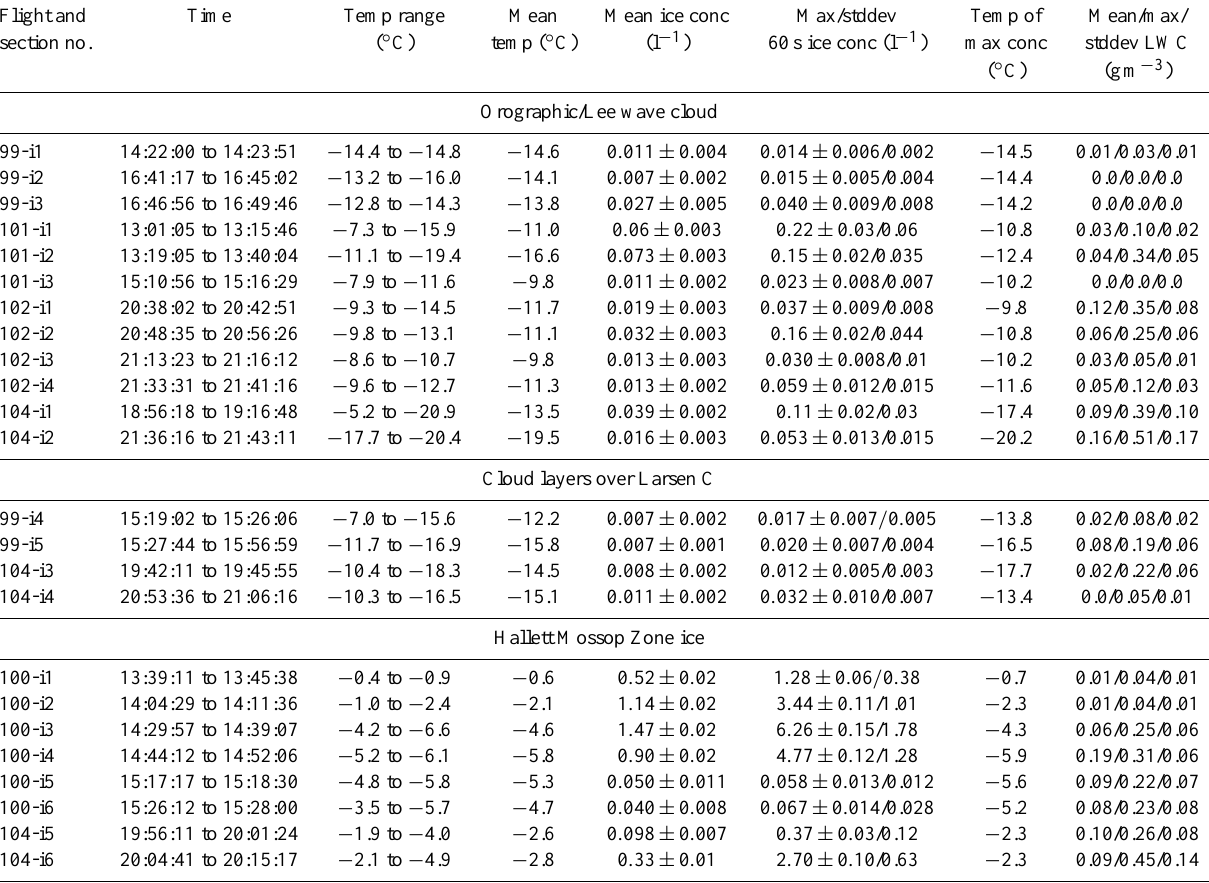
Table 1. Summary of the properties of periods of the different flights in which sustained ice was detected. See the text for details on the criteria for identifying these periods. The table has been split into periods of orographic or wave cloud, cloud observed over the Larsen C Ice Shelf and cloud observed in the Hallett Mossop temperature range.